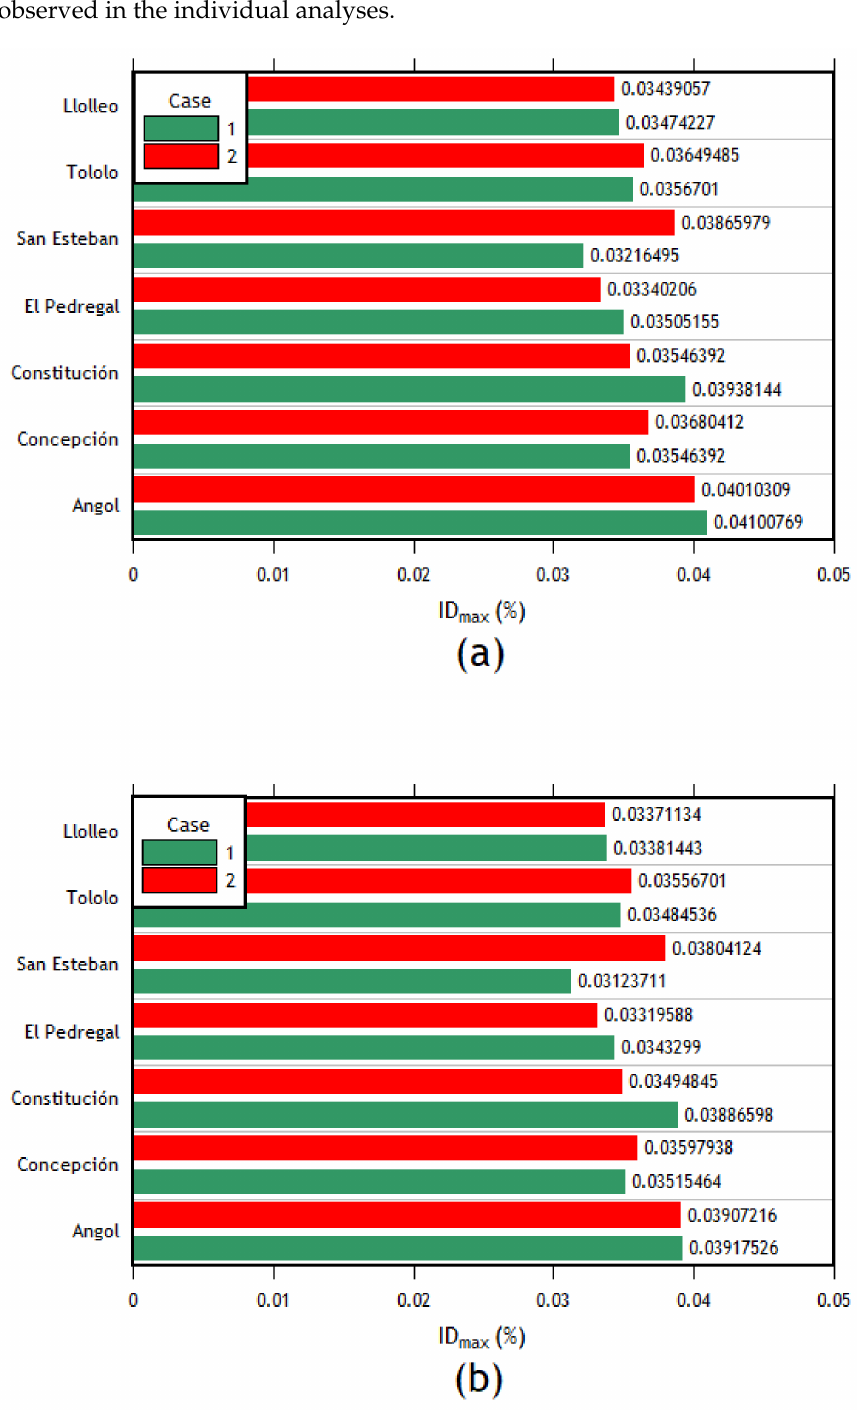
Figure 13. Interstory drifts of the ( a ) right column of frame 4 and ( b ) right column of frame 3, cases 1 and